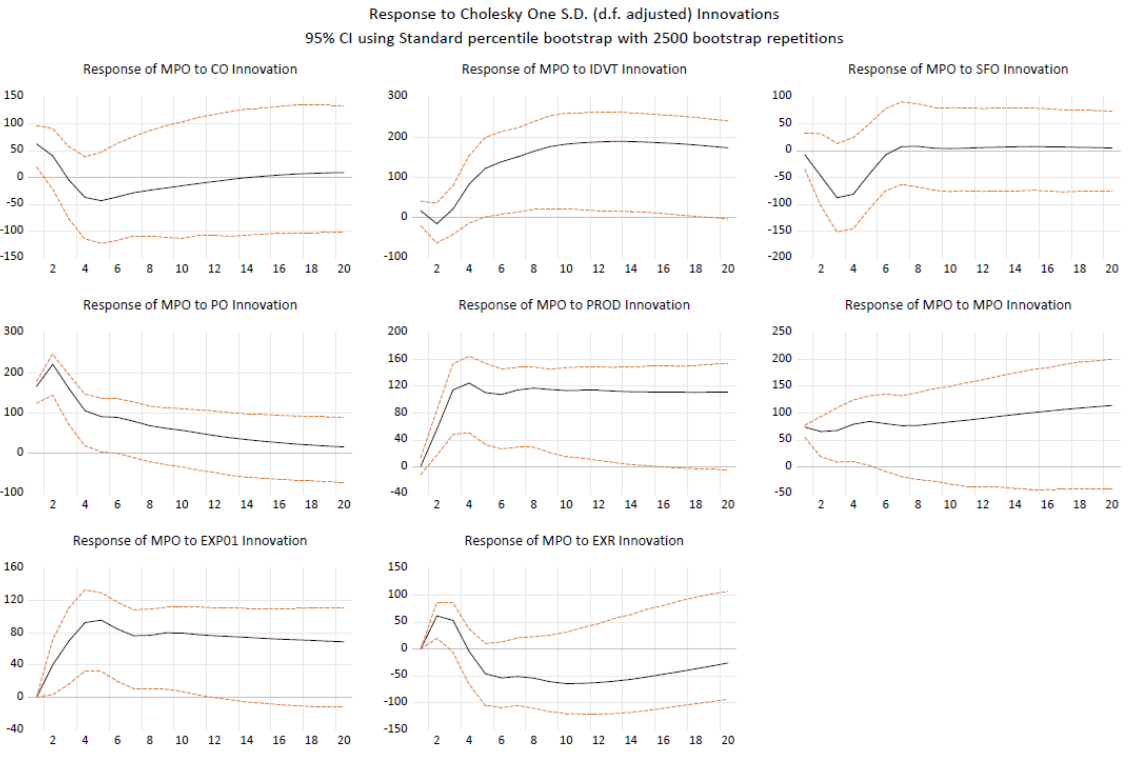
Figure 8. Impulse response after replacing IDVT with EPUI. 5. Conclusions This study aimed at extending past studies on the impact of shocks on palm oil price movement. For this purpose, it employed news − based indicators to represent economic shocks. The study covered the most recent period to evaluate the impact on Malaysian palm oil price and assess the stability and robustness of the forecast model adopted. The model was able to provide a meaningful impact analysis on Malaysian palm oil prices from external shocks and the findings are aligned with those of previous studies. Via forecast error variance decomposition, it was found that the external shocks were more influential in Malaysian palm oil price volatility than the internal shocks. However,